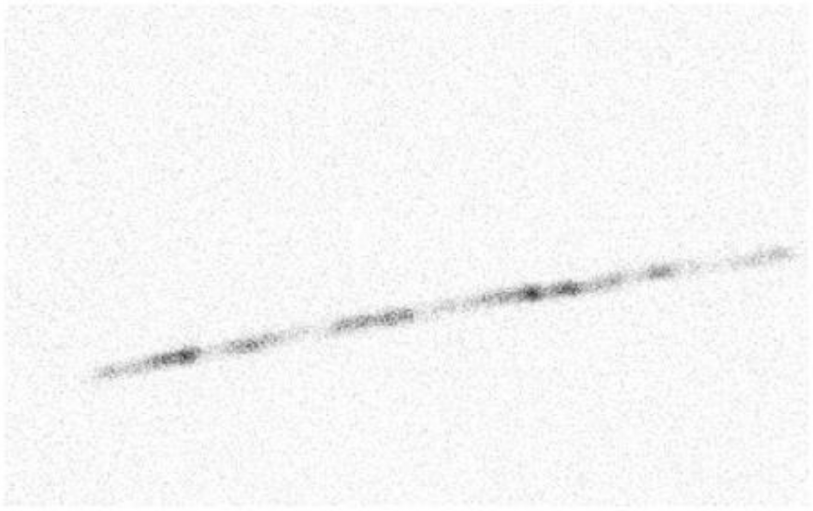
Figure 10. A gray color image of the 221st defective